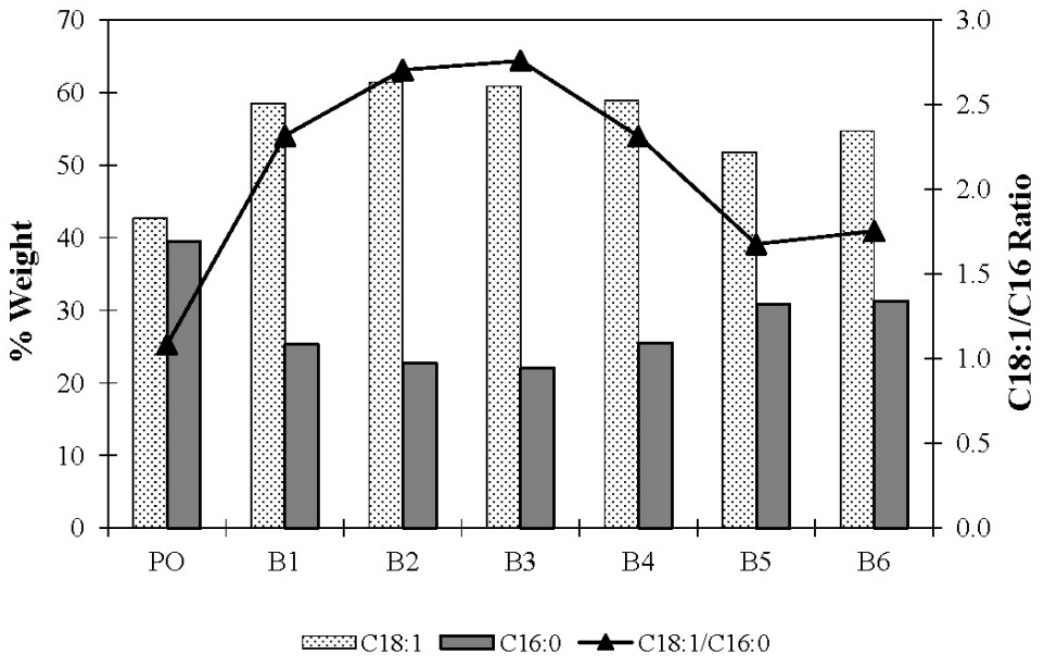
Figure 2. Composition of oleic acid and palmitic acid in starting material, palm olein and FFA fractions extracted from hydrolysates. PO: palm olein; B1-B6: mass culture of batch 1 to